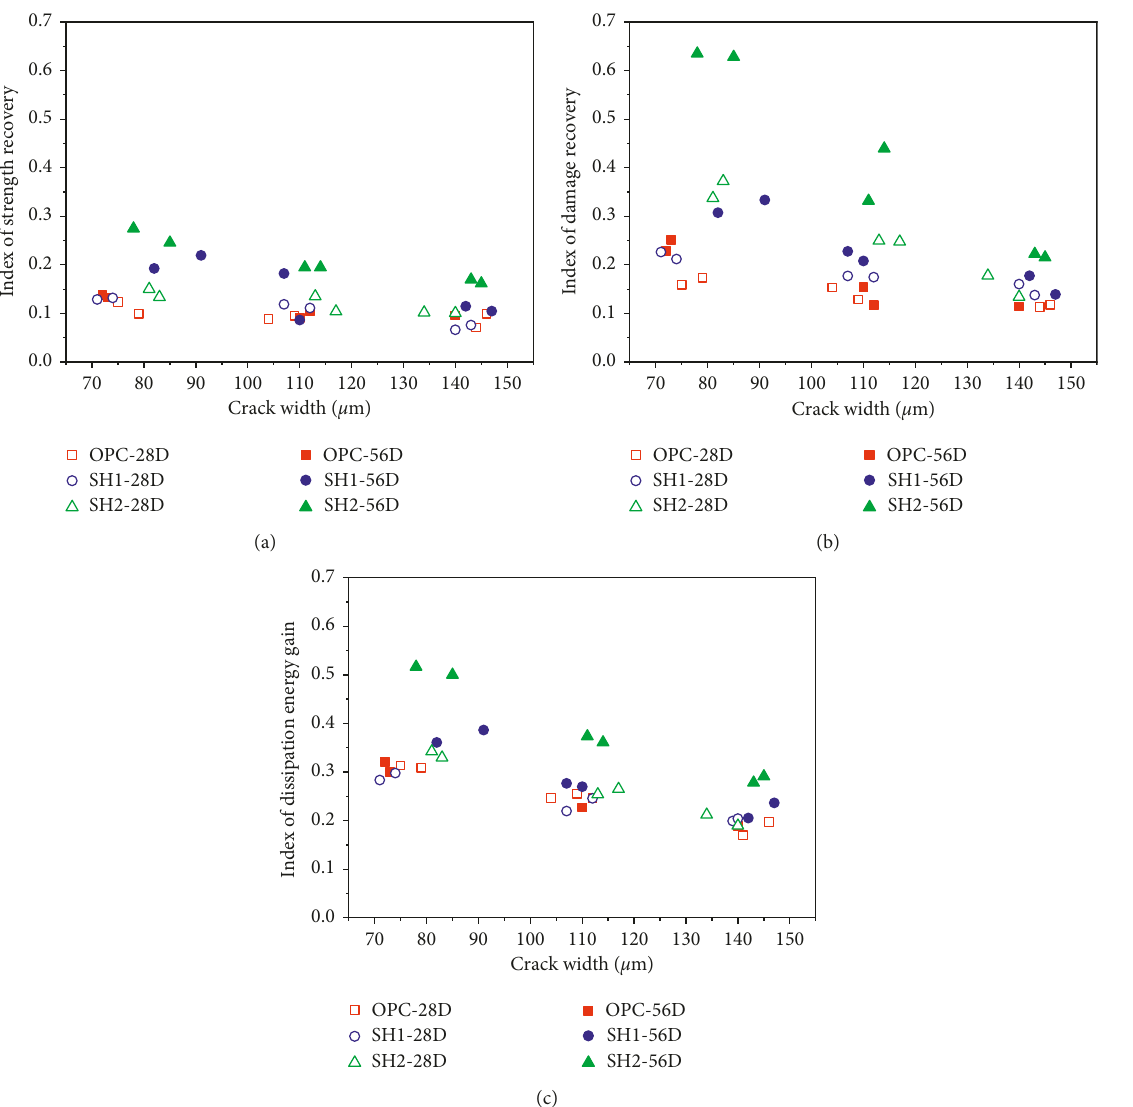
Figure 7: Indices of mechanical performance versus crack width: (a) index of strength recovery (ISR); (b) index of damage recovery (IDR); (c) index of dissipation energy gain